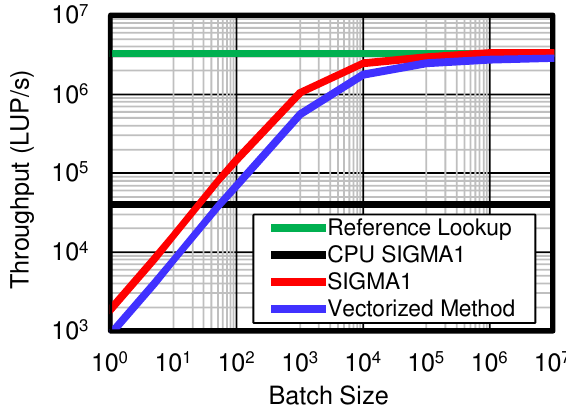
Figure 1. Throughput (in LUP/s) of cross section lookups for U-238 as a function of batch size for the various cross section lookup methodologies